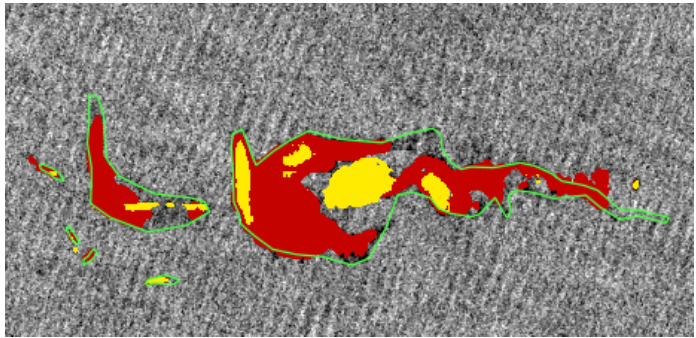
Figure 13. Sample of large slick and the corresponding prediction of FC-DenseNet and Mask R-CNN. Same legend as Figure 12.